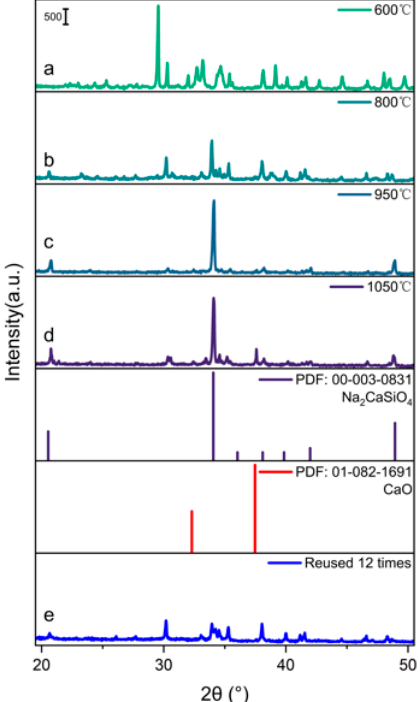
Figure 1. XRD spectrum of the NCSO catalyst calcinated at different temperatures ( a – d ) and the reused NCSO ( e ).